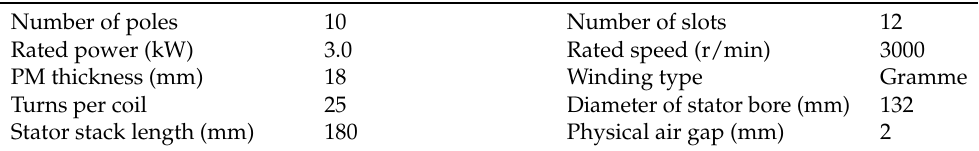
Table 1. DESIGN PARAMETERS OF THE